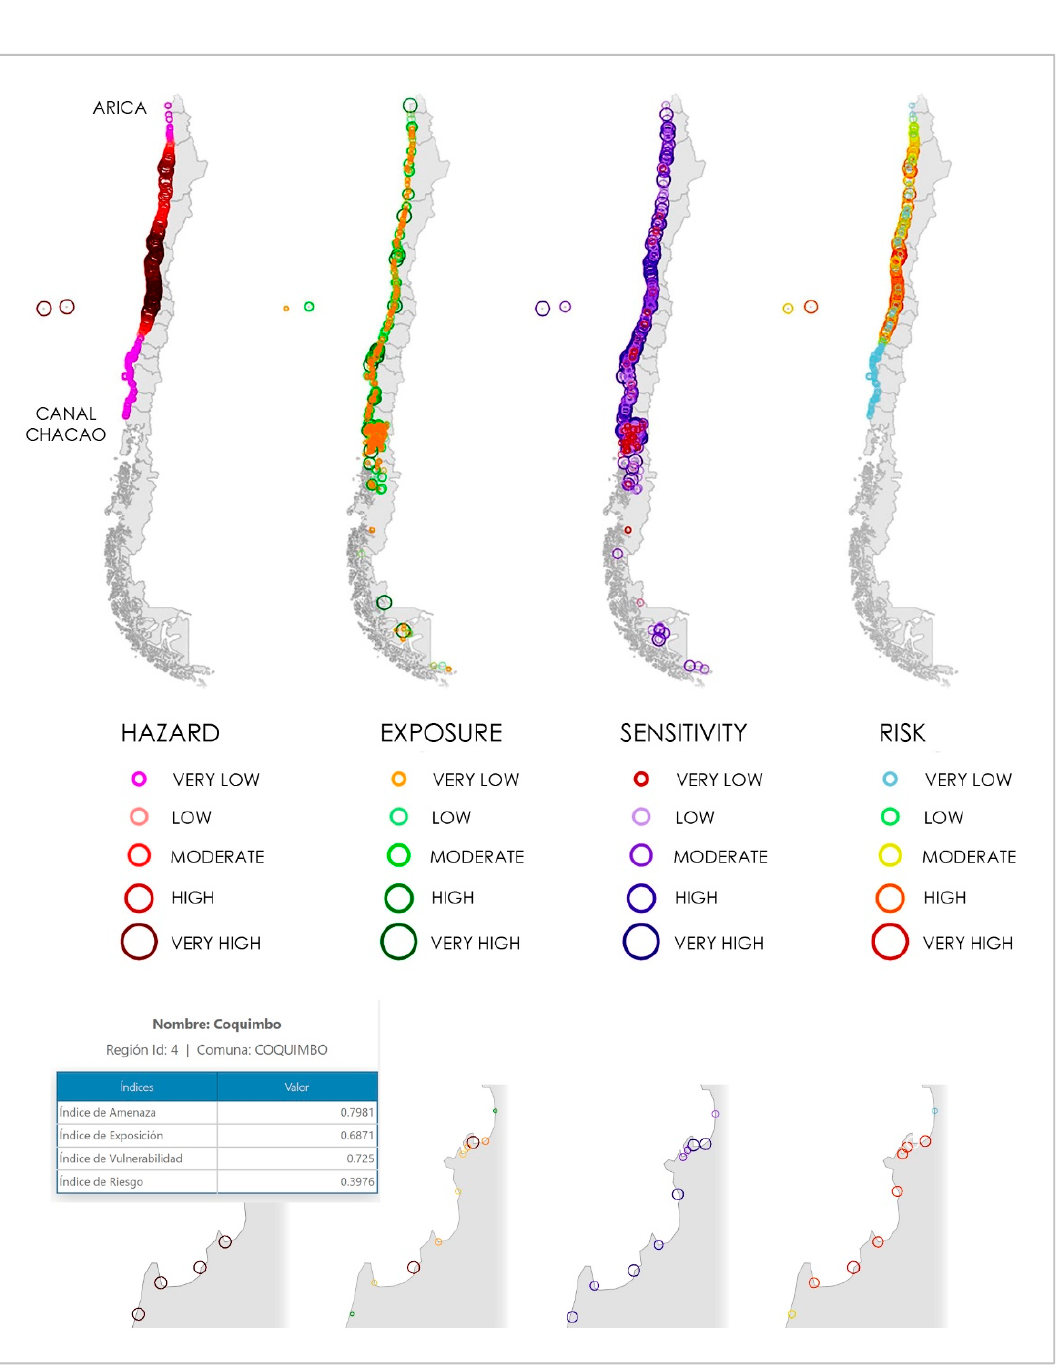
Figure 8. Top: Relative values of the hazard, exposure, sensitivity, and risk of fishing coves. Bottom: Zoomed-in view covering Coquimbo Bay and surroundings, including indices at Coquimbo fishing cove (36.530° W–72.959° W). Available at https://arclim.mma.gob.cl/atlas/view/caletas_pescadores/ (accessed on 12 October 2022).